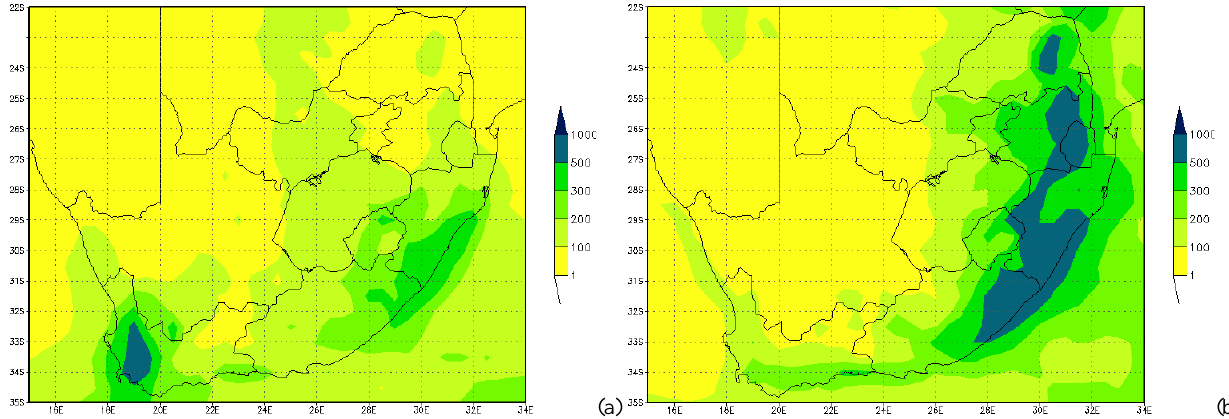
Fig. 9. UM stratiform rainfall for winter months (a) and summer months (b) for 2008 and